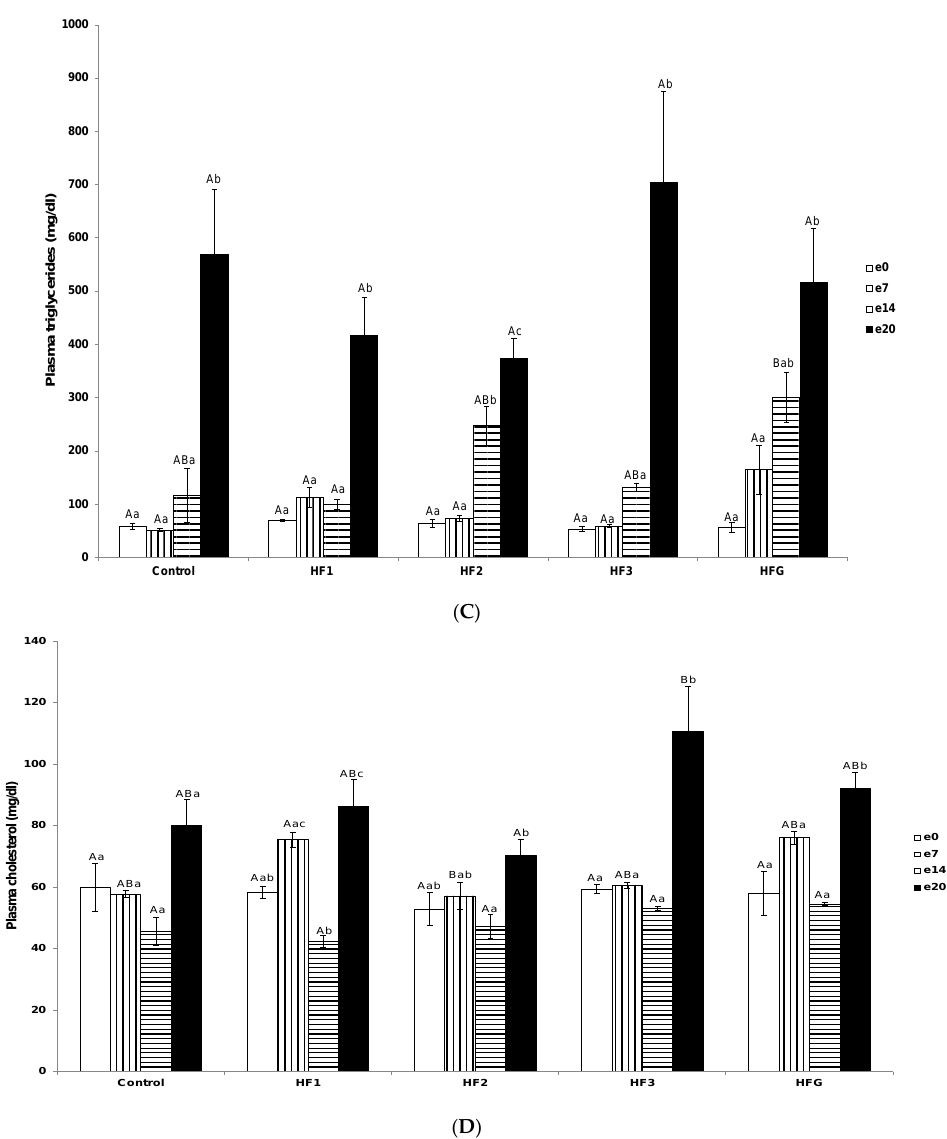
Figure 2. Lipid profiles during gestation. ( A ) Plasma non-esterified fatty acid concentrations (μM); ( B ) individual plasma fatty acid concentrations (mg/dL); ( C ) plasma triglyceride concentrations (mg/dL); and ( D ) plasma cholesterol concentrations (mg/dL). Numerals refer to the specific week of gestational high fat (HF) maintenance. G, gestation refers to HF maintenance throughout gestation. Values are means ± standard error of the mean (SEM). Capital letters refer to inter-groups. Lower case letters refer to intra-groups. Different letters reflect significant changes.